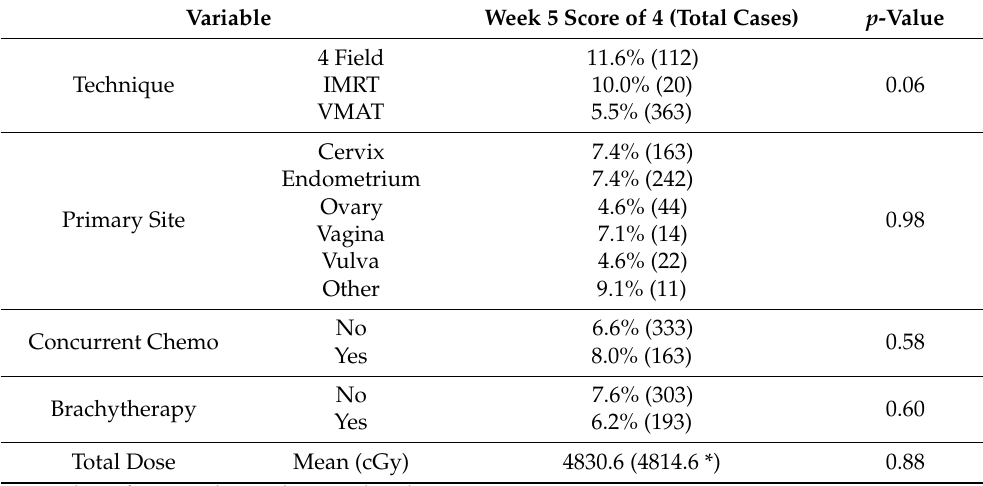
Table 4. Univariate analysis of increased week 2 GU toxicity leading to severe week 5 toxicity (using GU summary